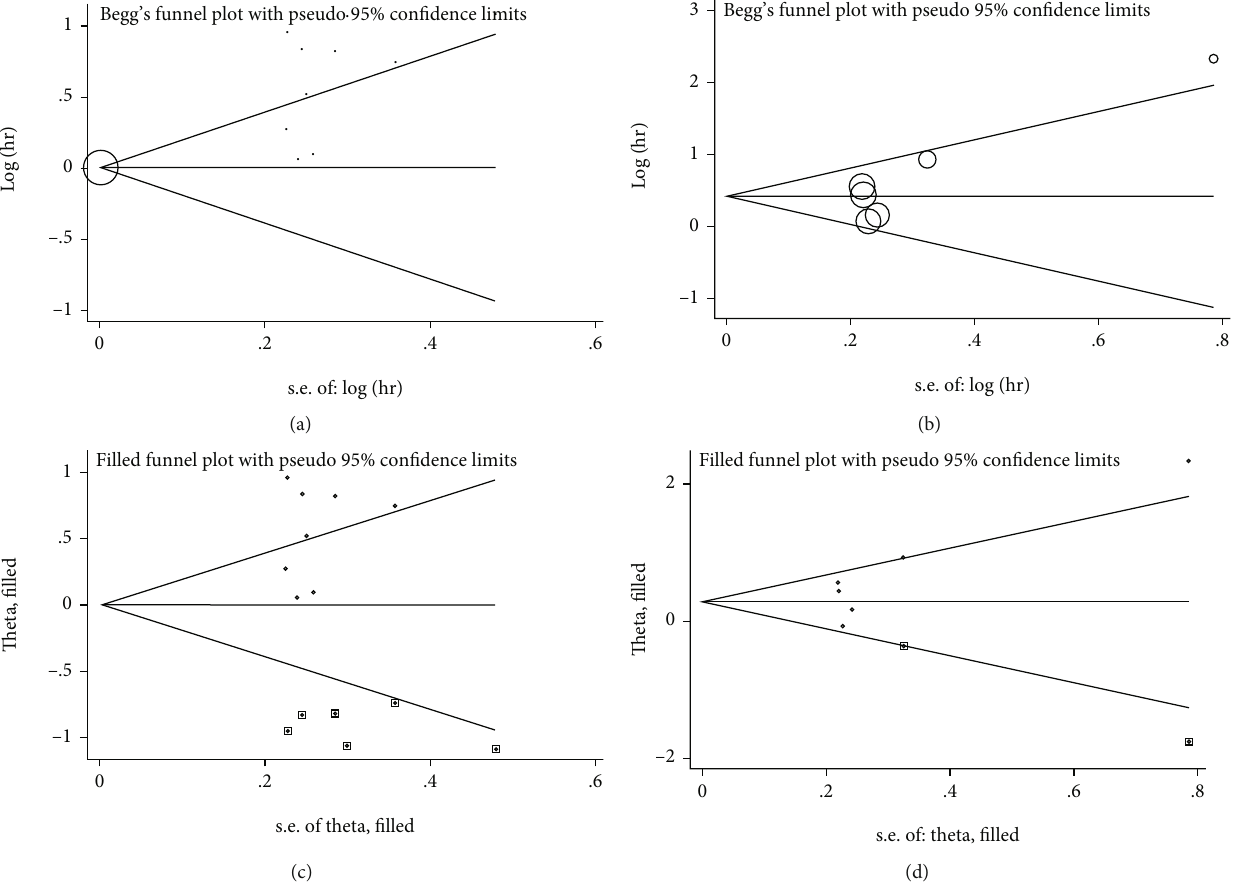
Figure 4: (a) Funnel plots assessing publication bias for OS. (b) Funnel plots assessing publication bias for PFS. (c) Trim-and- fi ll funnel plot for OS. (d) Trim-and- fi ll funnel plot for